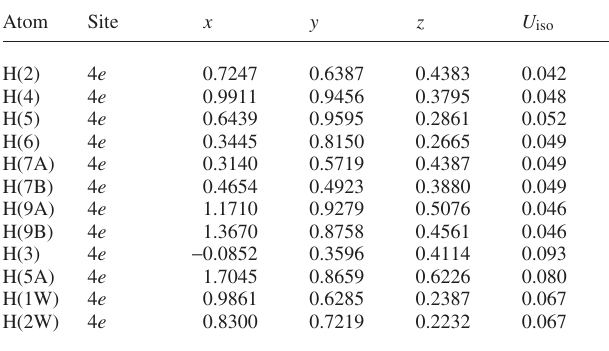
Table 2. Atomic coordinates and displacement parameters (in Å 2 )